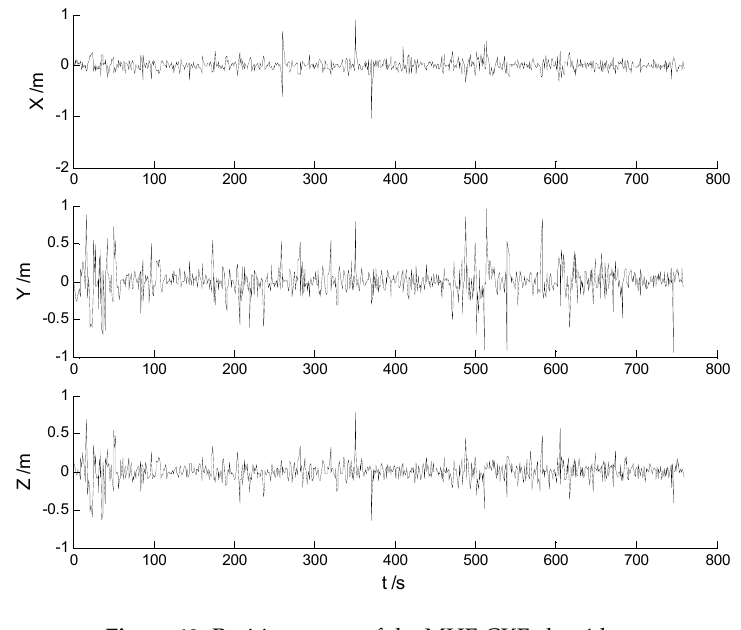
Figure 12. Position errors of the MHF-CKF algorithm.